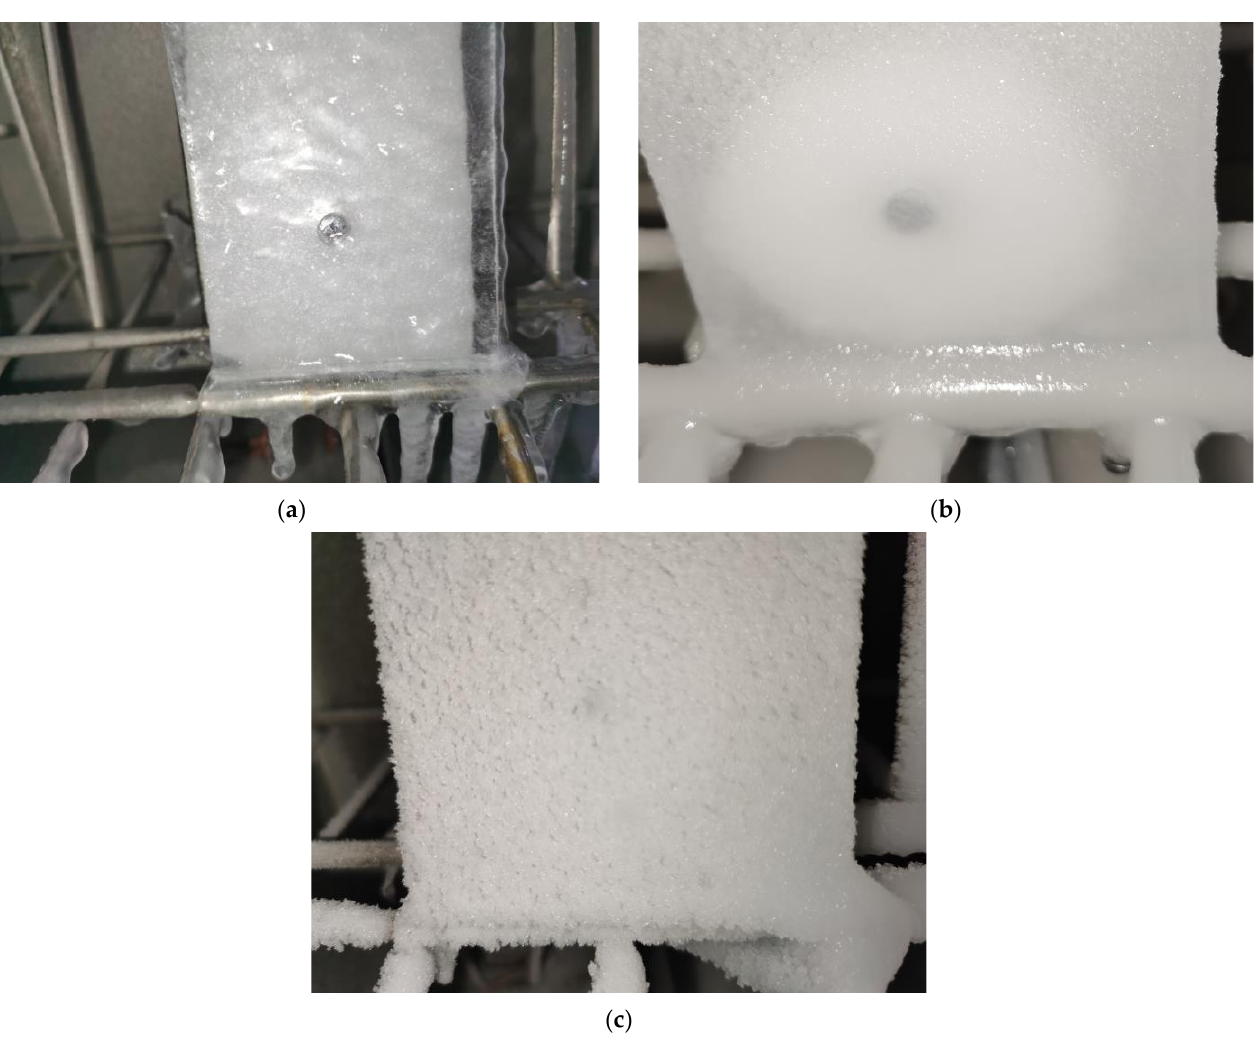
Figure 8. Three typical ice types for the low-temperature icing test: ( a ) glazed ice for −5 °C; ( b ) rime ice for −20 °C; ( c ) rime ice for −40 °C.